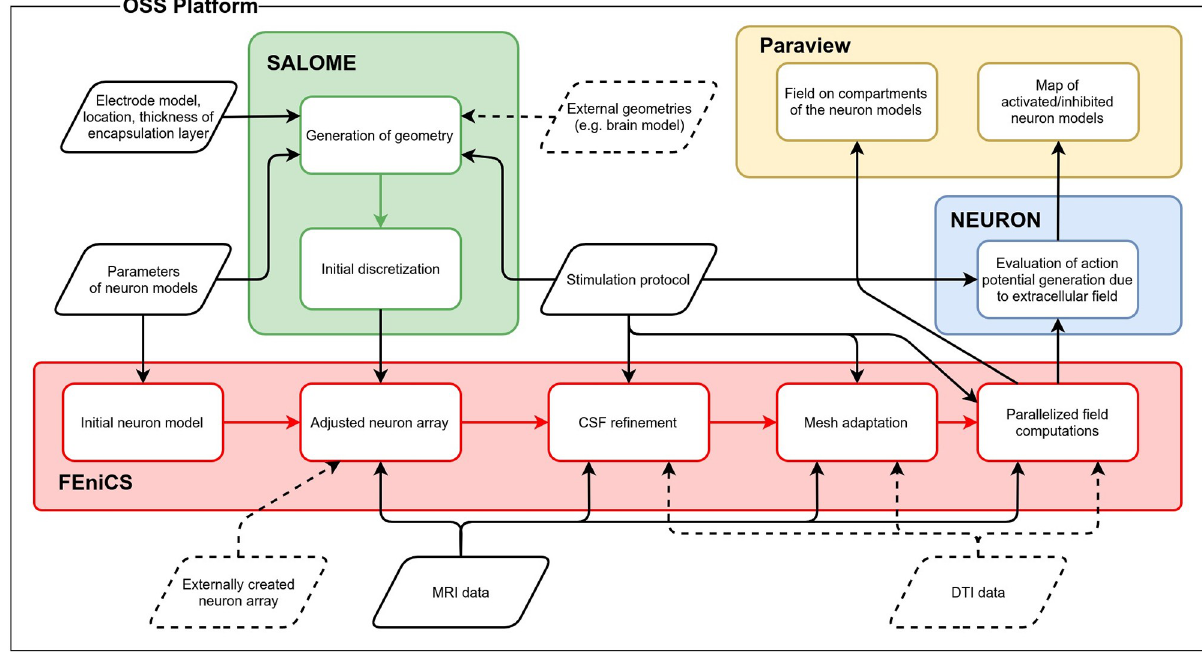
Fig 1. Flowchart diagram of OSS-DBS with its main CAD/CAE modules. Communication between and within the modules is conducted via various Python scripts, which form the core of the platform. Solid line parallelograms depict mandatory input data, while dashed ones are optional.